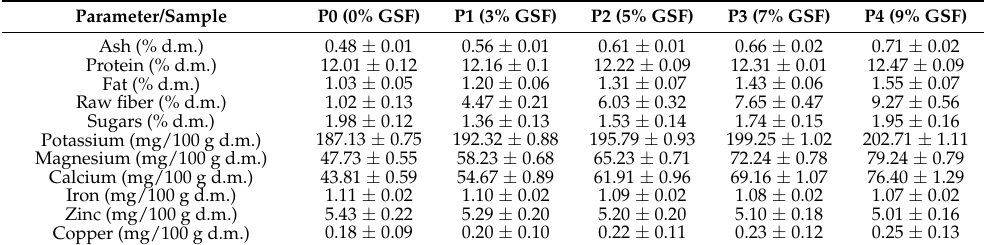
Table 6. Experimental results of the nutritional composition and mineral content of wheat flour mixtures with the addition of grape seed flour. Parameter/Sample P0 (0% GSF) P1 (3% GSF) P2 (5% GSF) P3 (7% GSF) P4 (9% GSF) Ash (%